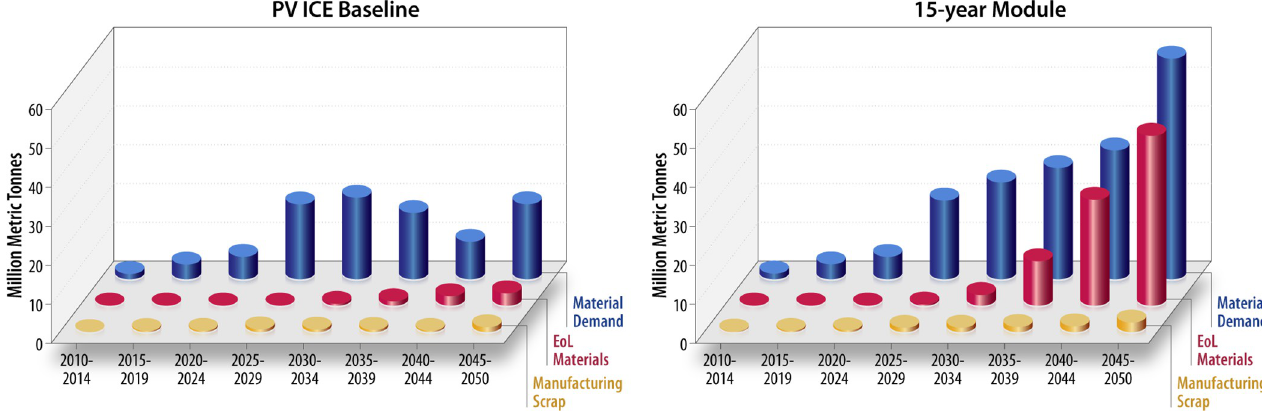
Fig 5. Time shift of material demand and EoL material availability. The 5-year summed material demand, EoL material, and manufacturing scrap for (a) the PV ICE baseline (~35-year module) and (b) a 15-year module. The material mass demands (blues) are the total material needed, which circular materials can offset. The EoL materials (red) and manufacturing scrap (yellow) are total material flows, assuming no circularity. All component materials are included.